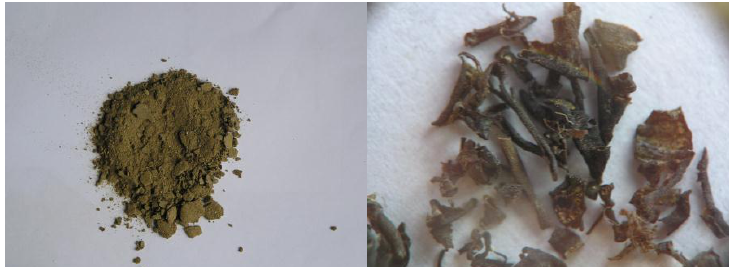
Figure 2. High porous charcoal prepared at thermal treatment of rice husk (left and middle images—electron microscopy, right—usual without magnification). Colloids Interfaces 2019 , 3 , x FOR PEER REVIEW